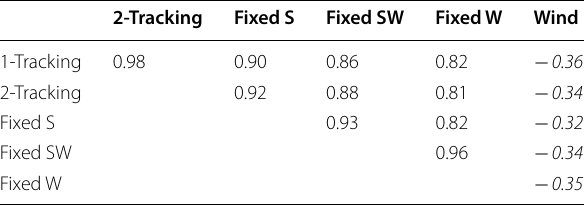
Negative correlations are highlighted in italicized